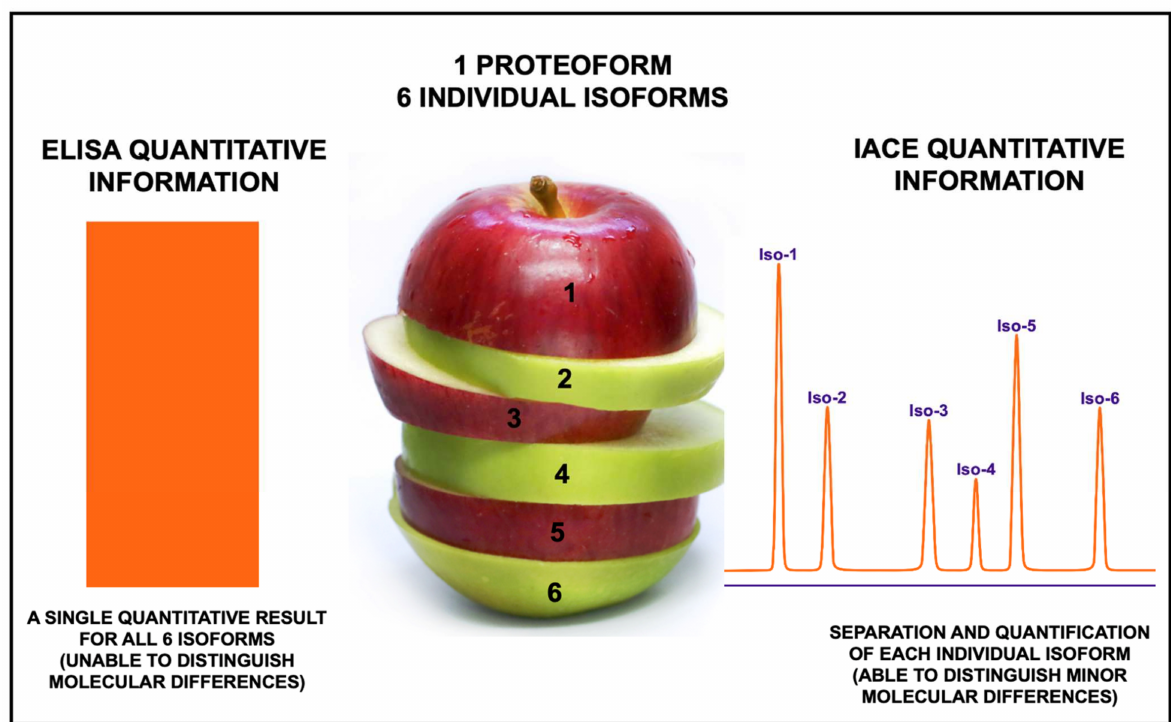
Figure 5. Depicts a schematic representing the main differences between the traditional mono-dimensional sandwich ELISA technique with the two-dimensional immuno-capture-separation IACE. The two-dimensional IACE technology can achieve the capture, separation, and partial characterization of each individual